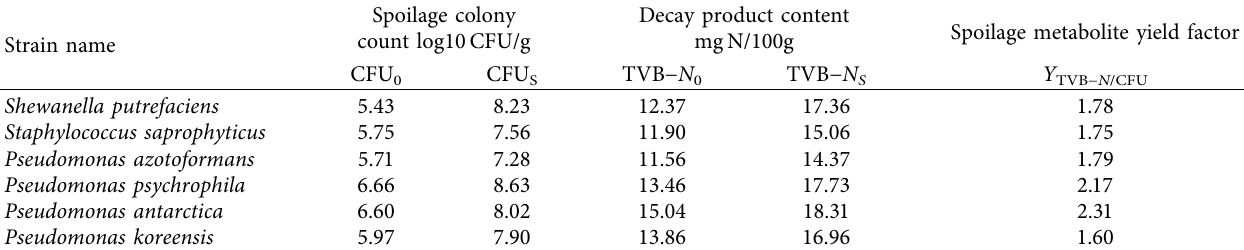
Table 1: Analysis of the corrosion ability of grouper inoculated with specific spoilage bacteria at 4 ° C.